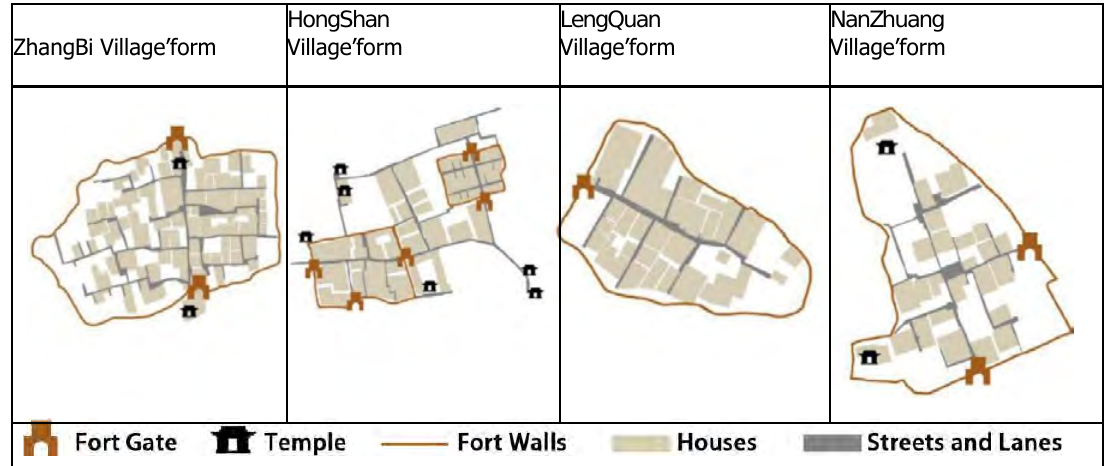
Figure 5 Four villages’ spatial